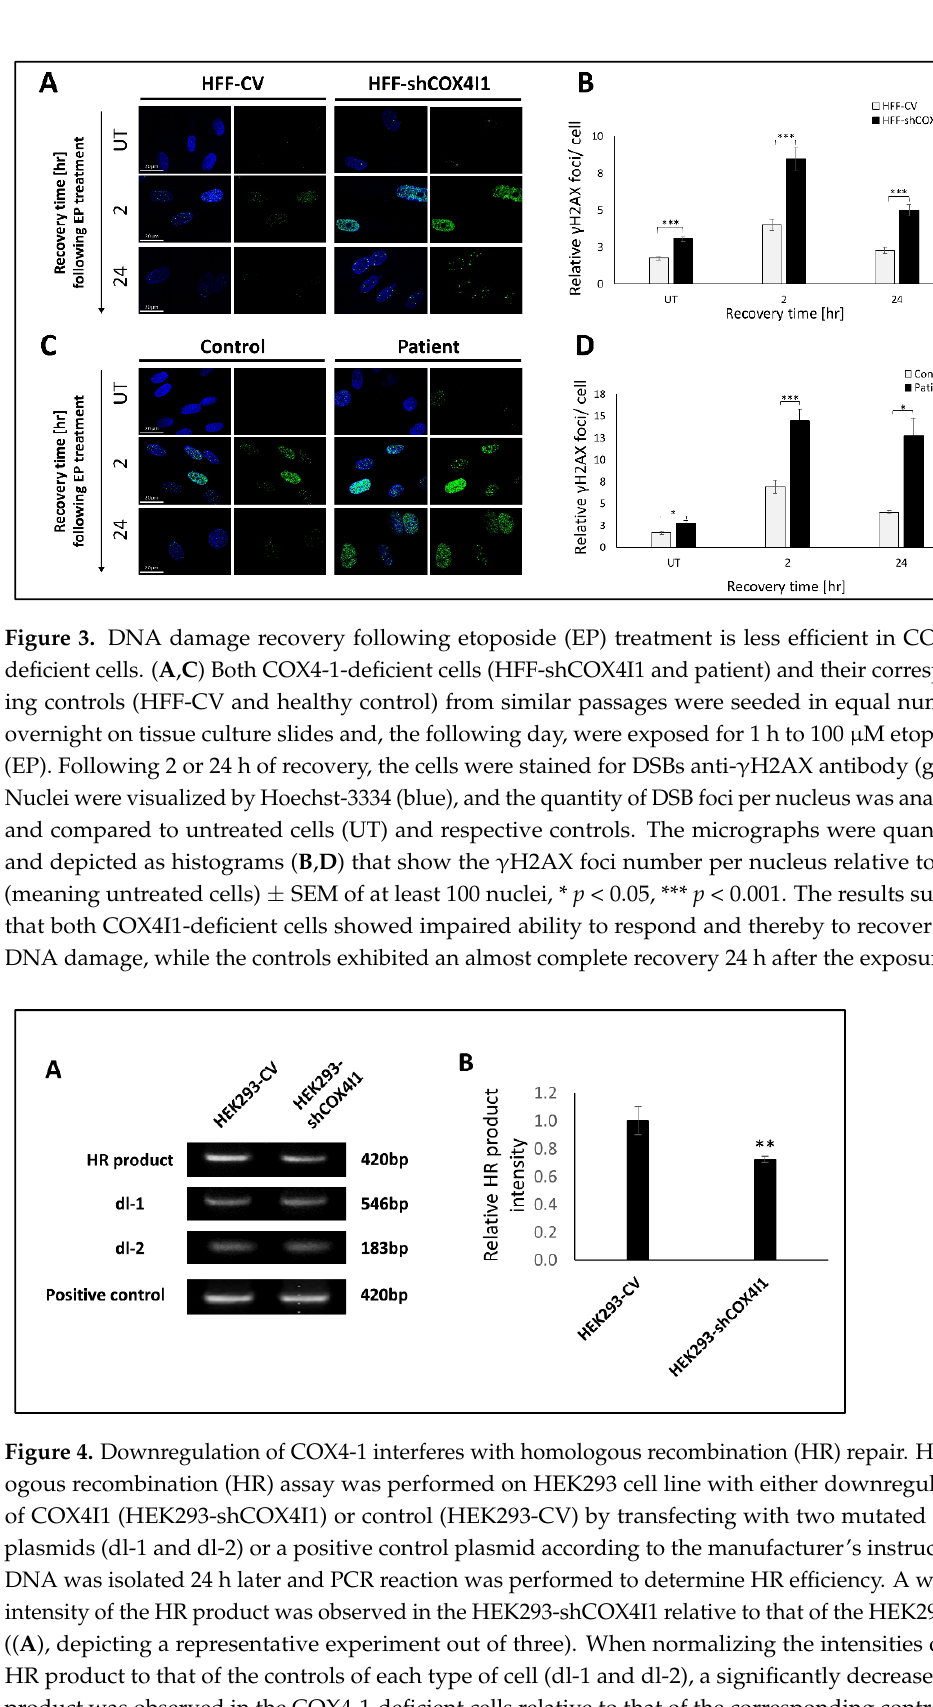
Figure 4. Downregulation of COX4-1 interferes with homologous recombination (HR) repair. Homologous recombination (HR) assay was performed on HEK293 cell line with either downregulation of COX4I1 (HEK293-shCOX4I1) or control (HEK293-CV) by transfecting with two mutated assay plasmids (dl-1 and dl-2) or a positive control plasmid according to the manufacturer’s instructions. DNA was isolated 24 h later and PCR reaction was performed to determine HR efficiency. A weaker intensity of the HR product was observed in the HEK293-shCOX4I1 relative to that of the HEK293-CV (( A ), depicting a representative experiment out of three). When normalizing the intensities of the HR product to that of the controls of each type of cell (dl-1 and dl-2), a significantly decreased HR product was observed in the COX4-1-deficient cells relative to that of the corresponding control ( B ). Values are normalized to the mean value of the control ± SEM; ** p < 0.01, n = 3.